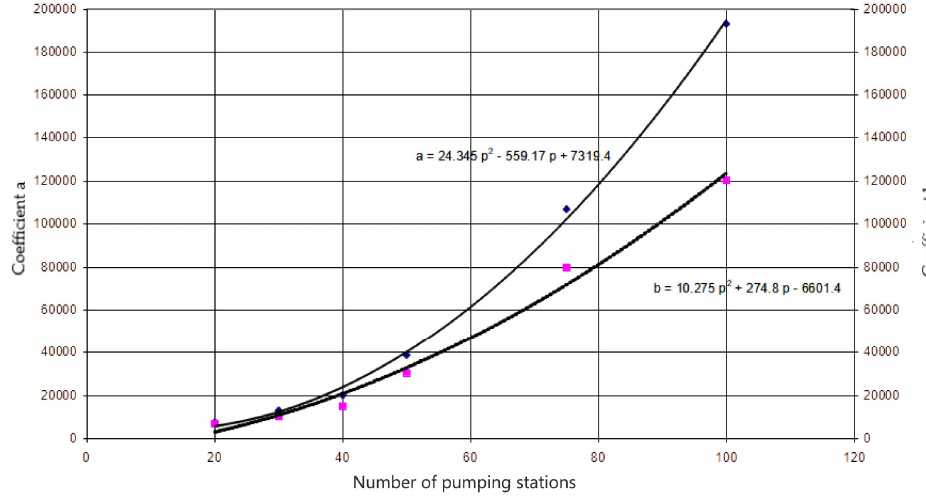
Figure A2. Relationships for functioning of working pumps.